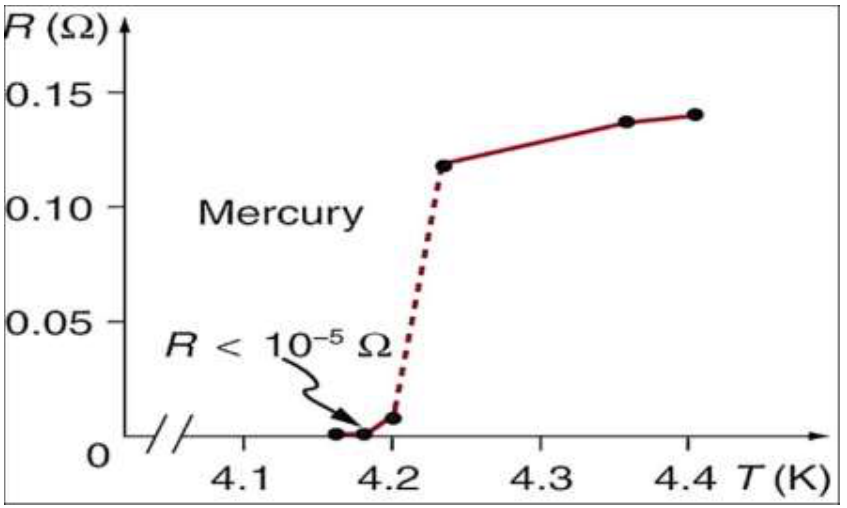
Figure 1: Mercury Superconductor transition